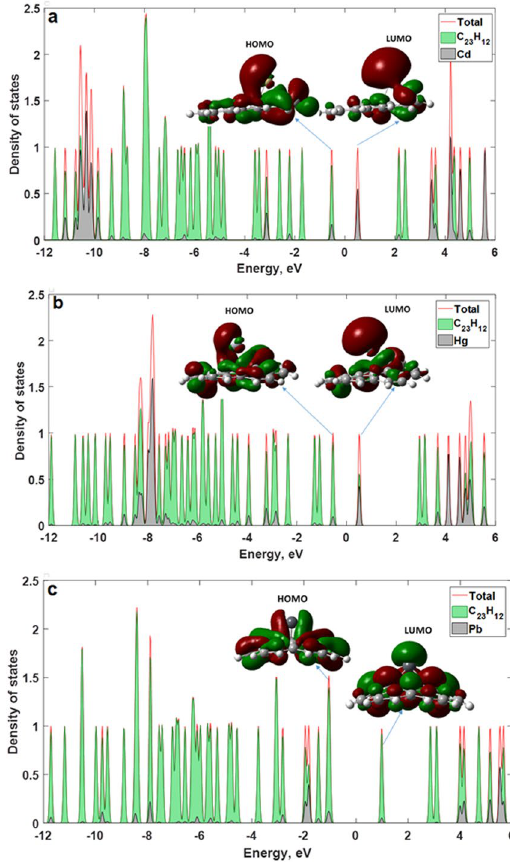
Figure 11. Total and projected DOS (PDOS) for graphene quantum dots with atoms of the heavy metals, which substitute the carbon ones in planar structure: C 23 H 12 cluster with Cd ( a ), C 23 H 12 cluster with Hg ( b ) and C 23 H 12 cluster with Pb ( c ). Insets represent corresponding iso-surfaces of the molecular orbitals. The Fermi level is set to be at zero (midgap) by defining E F = (E HOMO + E LUMO